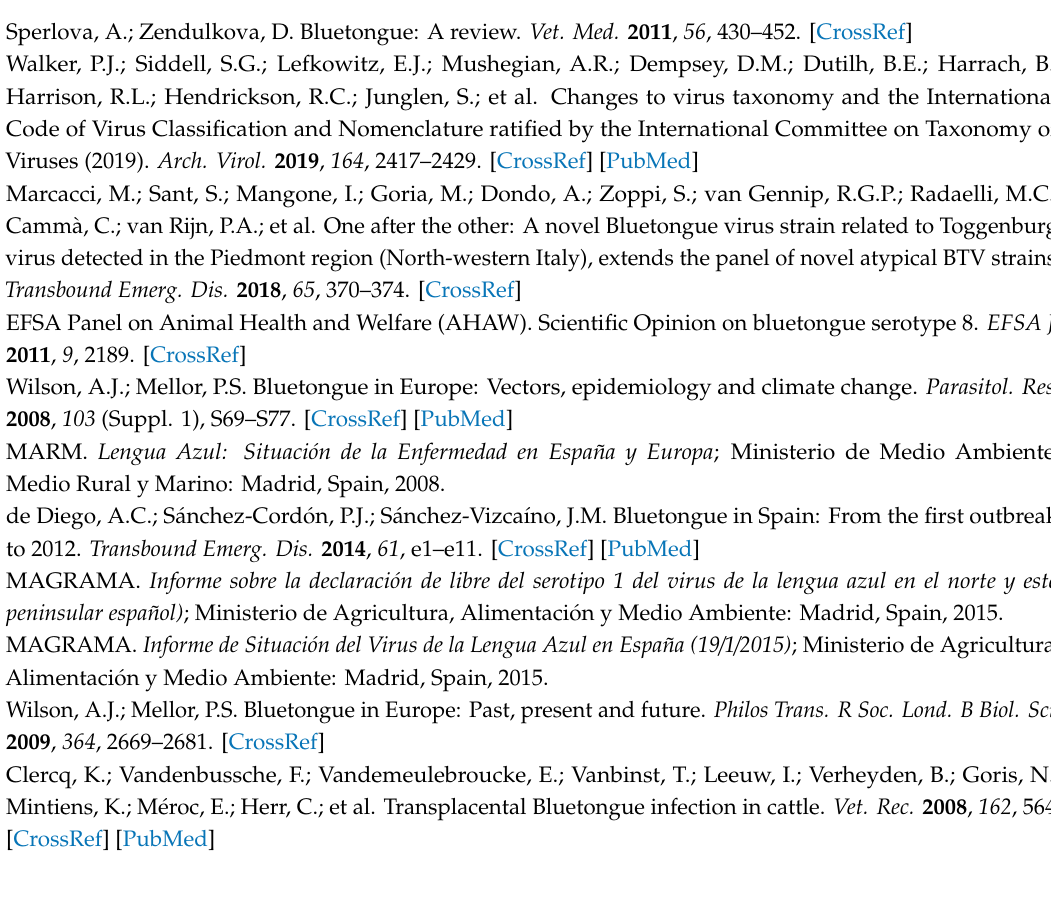
Table S1: Monthly numbers and percentages of Culicoides spp. positive catches (presence) in the entire dataset and in the occurrence models training dataset after the application of the Synthetic Minority Over-sampling Technique (SMOTE) algorithm, Table S2: Culicoides spp. occurrence and abundance models performance, Table S3: Monthly variable importance of the Culicoides spp. occurrence models through the mean decrease Gini (MDG), and abundance models through the increase in node purity (INP), Figure S1: WorldClim monthly mean temperatures for mainland Spain and the Balearic Islands. The climatic data presented here is available online: https: // worldclim.org / . Administrative boundaries provided by Instituto Geogr á fico Nacional (ign.es); BDDAE CC-BY